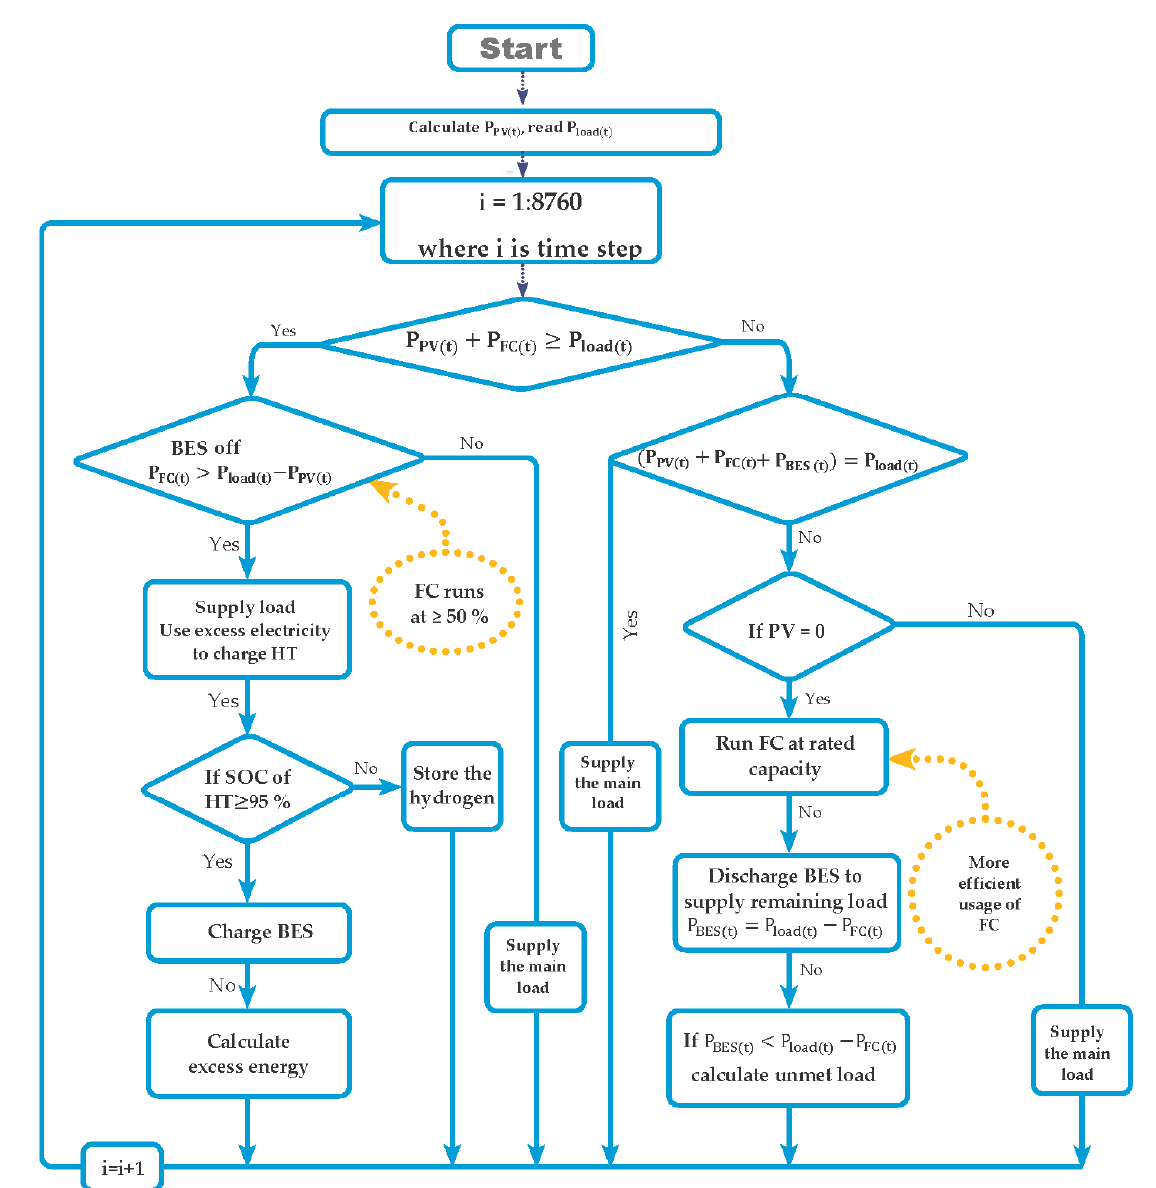
Figure 5. Control algorithm for PD strategy.